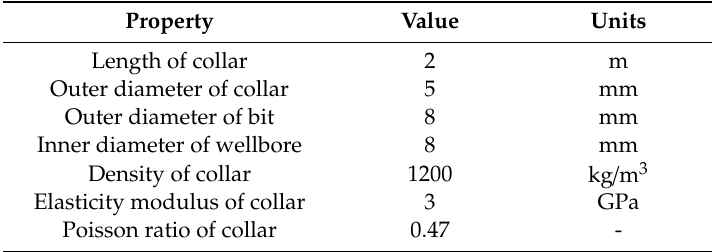
( h ) Figure 7. Trajectory curve of BHA center under different positions: ( a–d ) are the numerical simulation results with 1.0 m, 0.3 m, 0.1 m, and 0.05 m respectively; ( e–h ) are the experimental results with 1.0 m, 0.3 m, 0.1 m, and 0.05 m respectively.